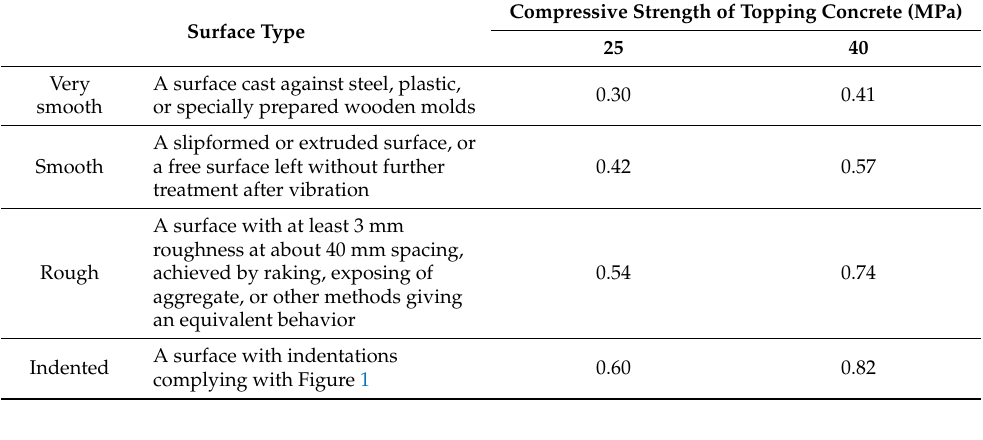
Table 1. Interfacial horizontal shear strength specified in EC 2 [8,26].